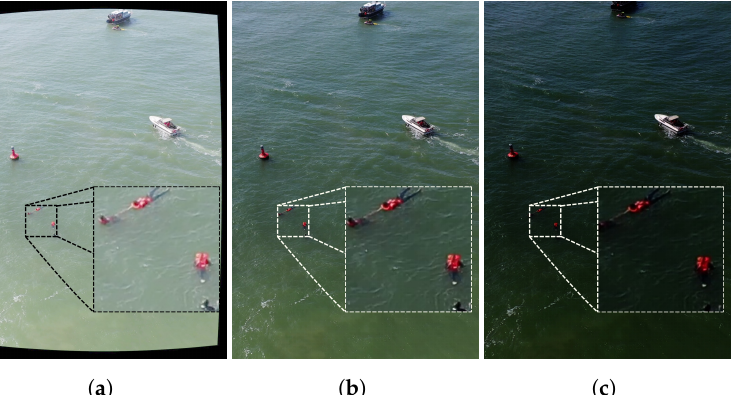
Figure A3. Example images for Camera Calibration. ( b ) Rectified. ( a ) and ( c ) mimic invalid exposure time and lense